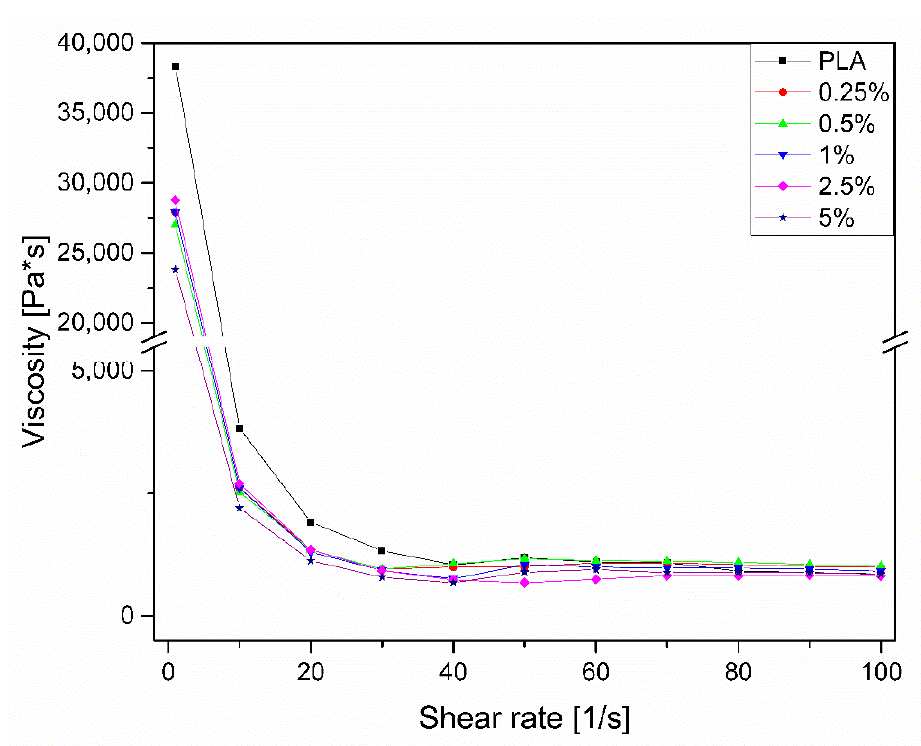
Figure 2. Result of MFR measurements.